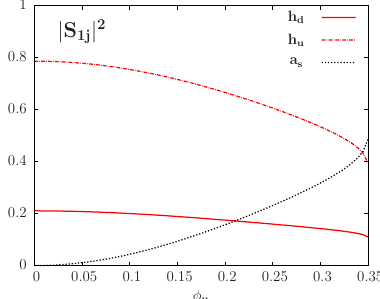
Figure 8. The decomposition of the lightest Higgs state H 1 in terms of the Higgs electroweak eigenstates as a function of the phase φ u